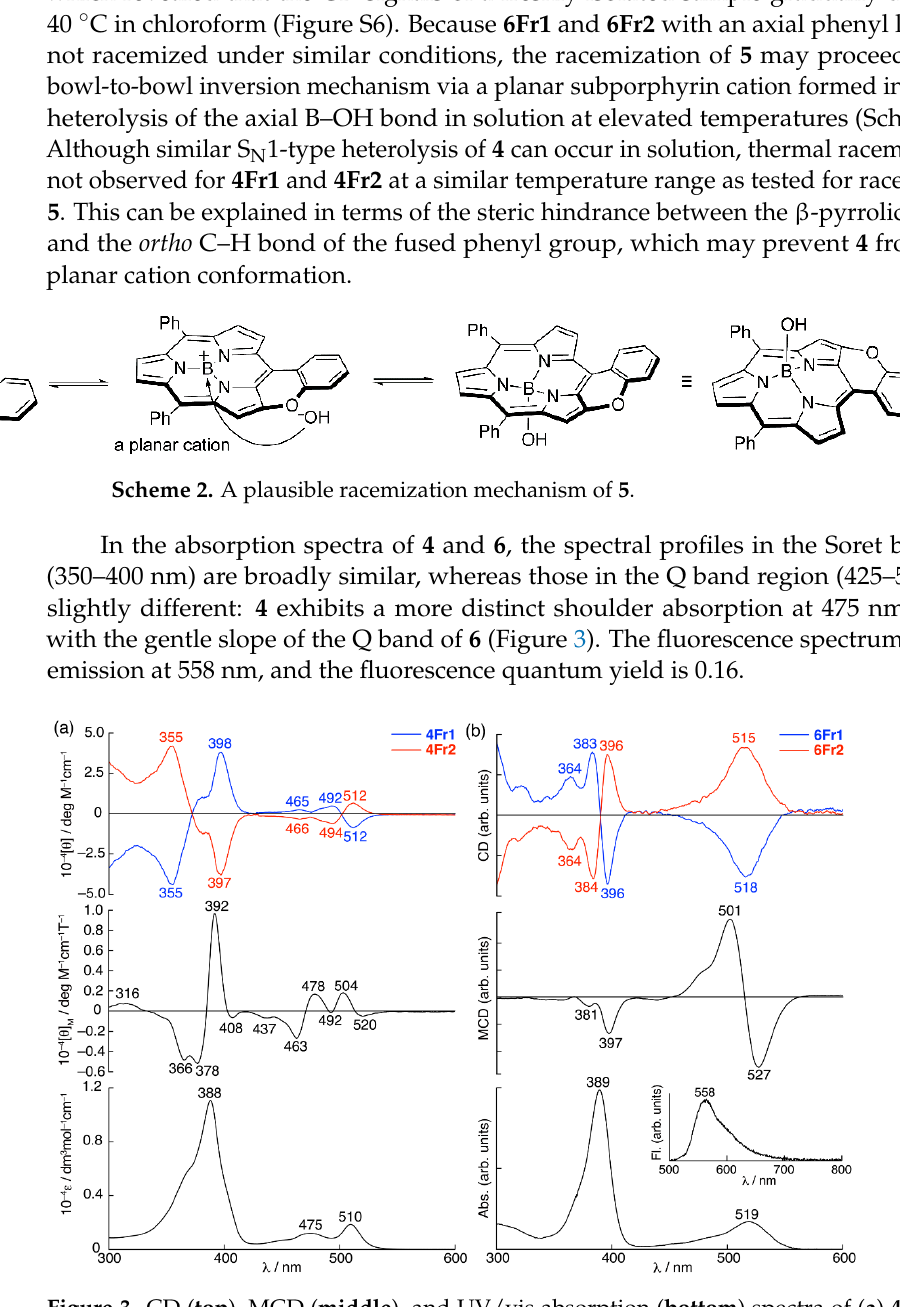
Figure 3. CD ( top ), MCD ( middle ), and UV/vis absorption ( bottom ) spectra of ( a ) 4 and ( b ) 6 in CH 2 Cl 2 . The CD spectra of the first eluted fractions ( 4Fr1 and 6Fr1 ) and the second eluted fractions ( 4Fr2 and 6Fr2 ) are shown by blue and red lines, respectively. Inset: fluorescence spectrum of 6 in CH 2 Cl 2 .